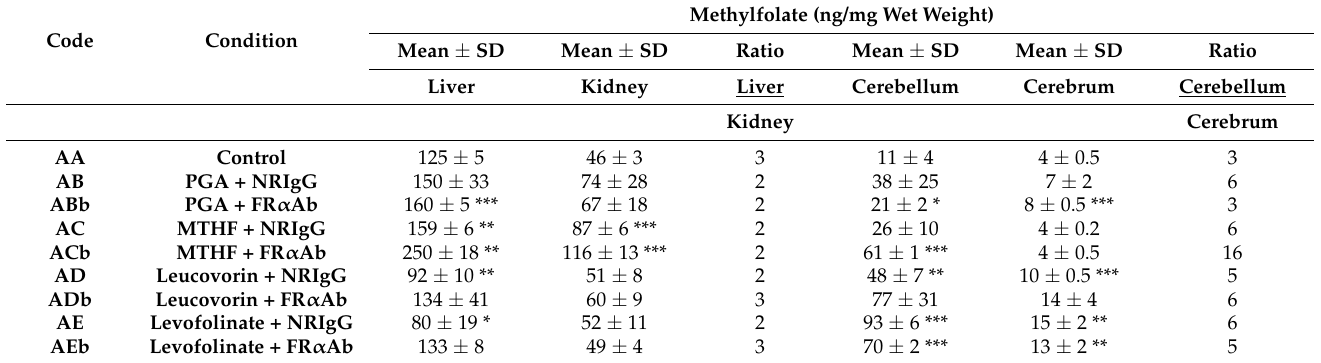
Table 1. Tissue concentration of methylfolate following orally administered folate forms 24 h post dosing and the effect of FR α Ab on this distribution in PND23 rat pups ( n =